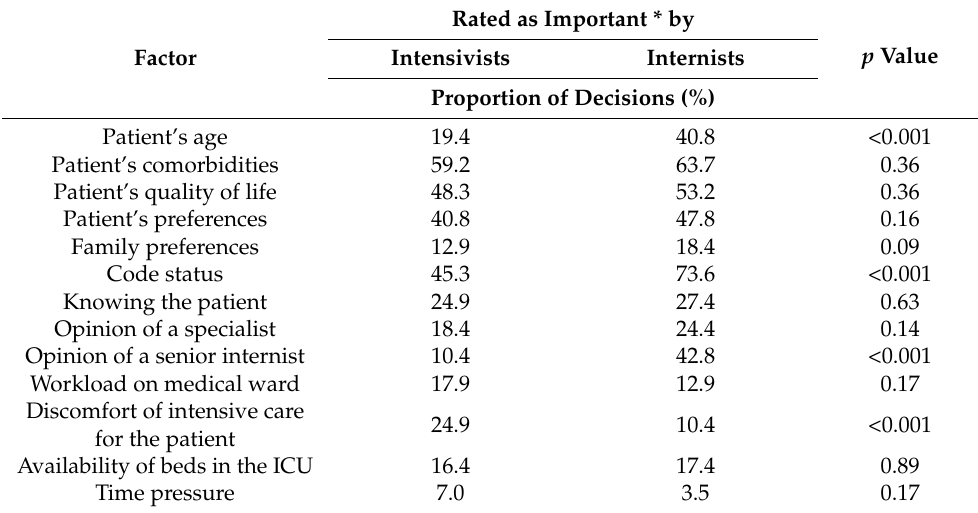
Table 1. Opinions of the intensivist and the internist about the importance of specific factors in the decision to admit or not admit a patient to intensive care, in 201 decisions.